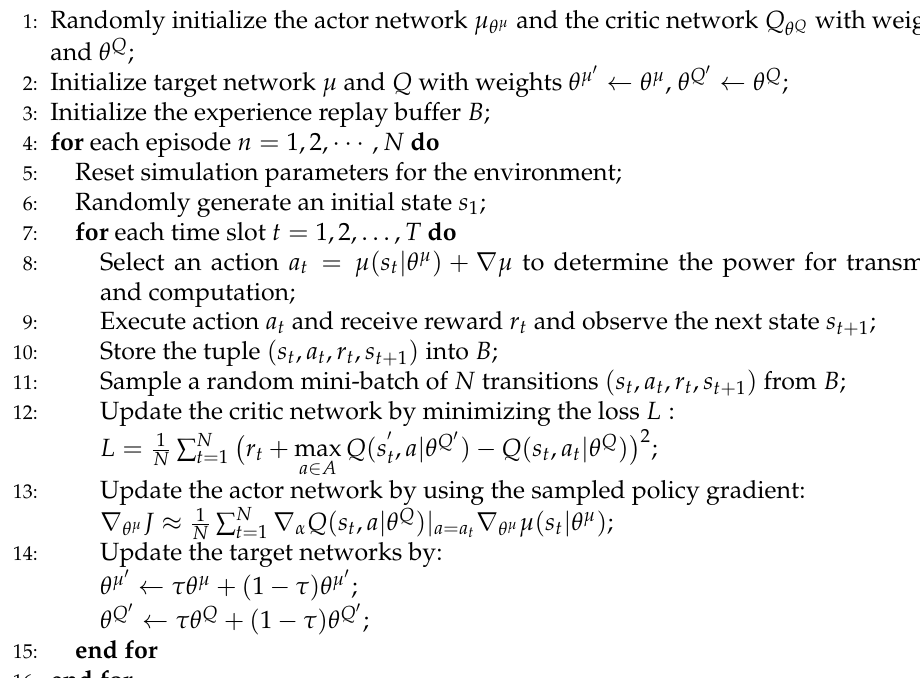
Algorithm 2 The DDPG-based Offloading